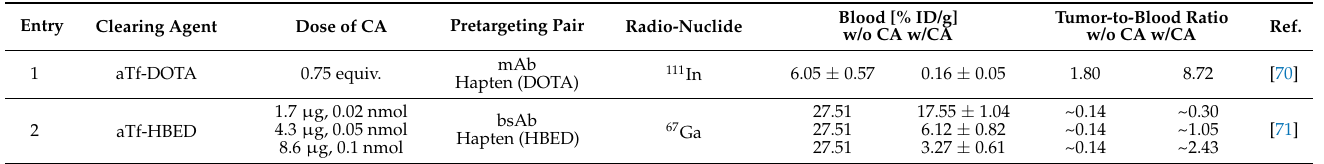
Table 3. Overview of apotransferrin-based clearing